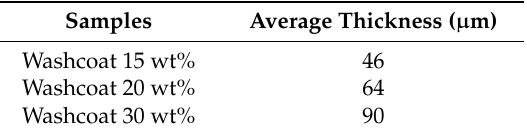
Table 3. Average thickness of washcoat layer.